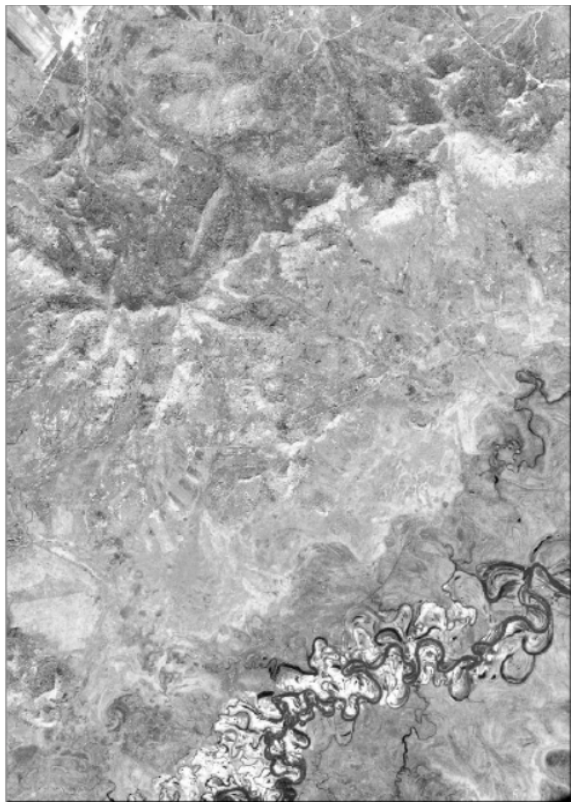
Figure 2. CORONA black-and-white images.